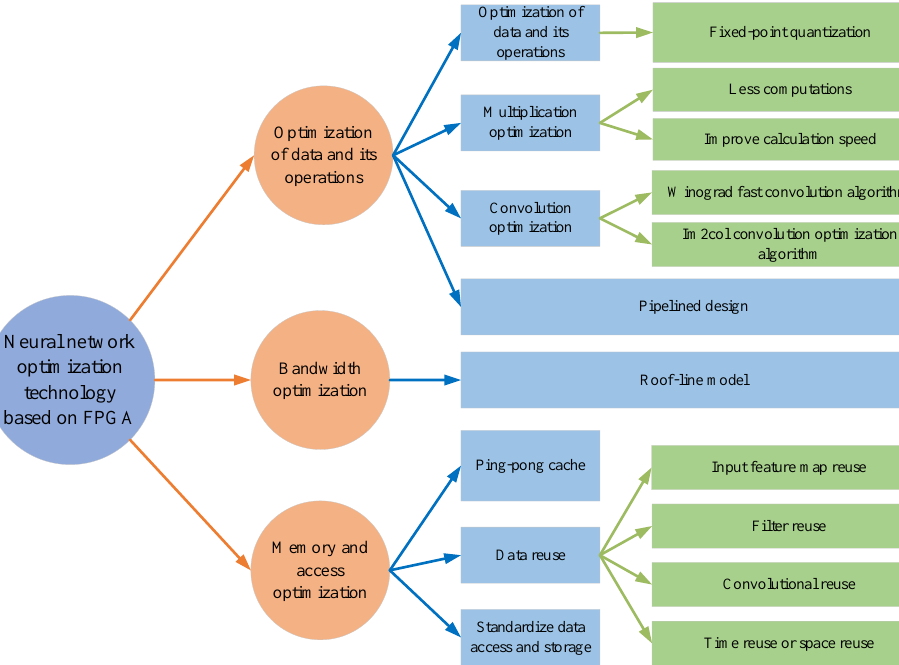
Figure 6. Neural network optimization technology based on FPGA.(fixed-point quantization [71–78], less computations [79–81], improve calculation speed [82–85], Winograd fast convolution